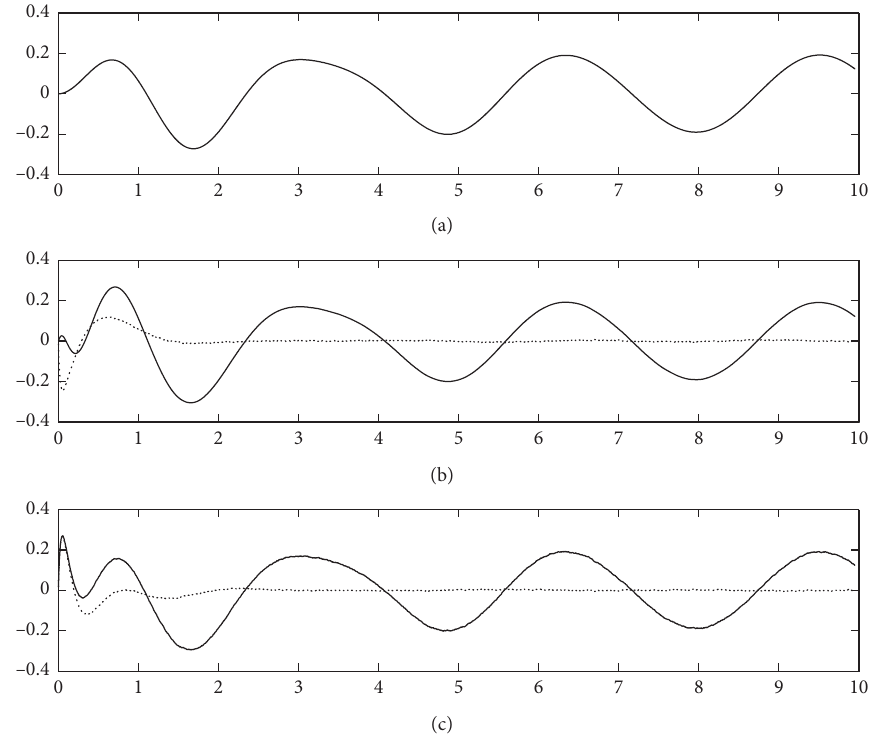
Figure 9: Tracking control of continuous-time chaotic system with trajectories (a) x